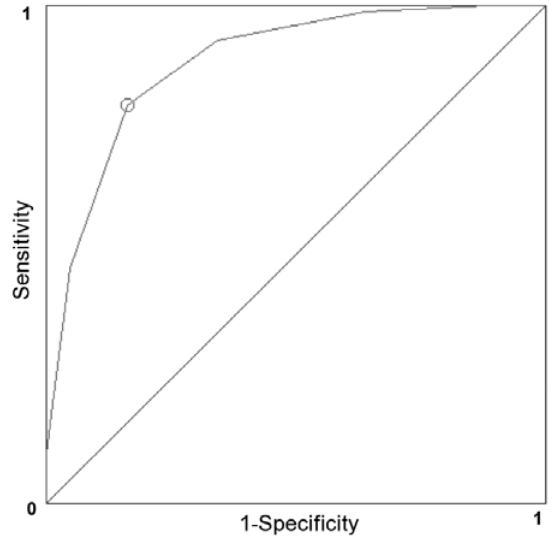
Figure 3. Analysis of molecular fingerprints according to receiver operating characteristic (ROC). Attributes were identified by ant colony optimization (ACO). Fingerprints were selected from the MACCS key set and consisted of nine fingerprints (Table 4). Cut-off value is denoted with a small